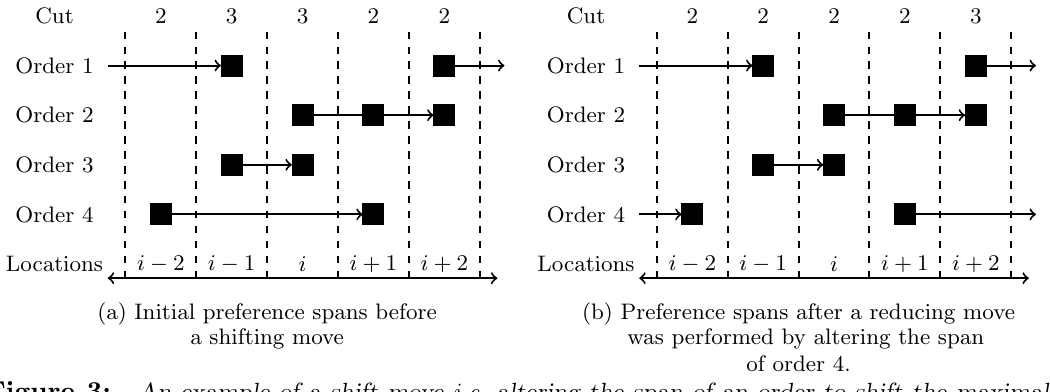
An example of a shift move i.e. altering the span of an order to shift the maximal cut. A filled square represents a location containing a SKU that is required by that order.